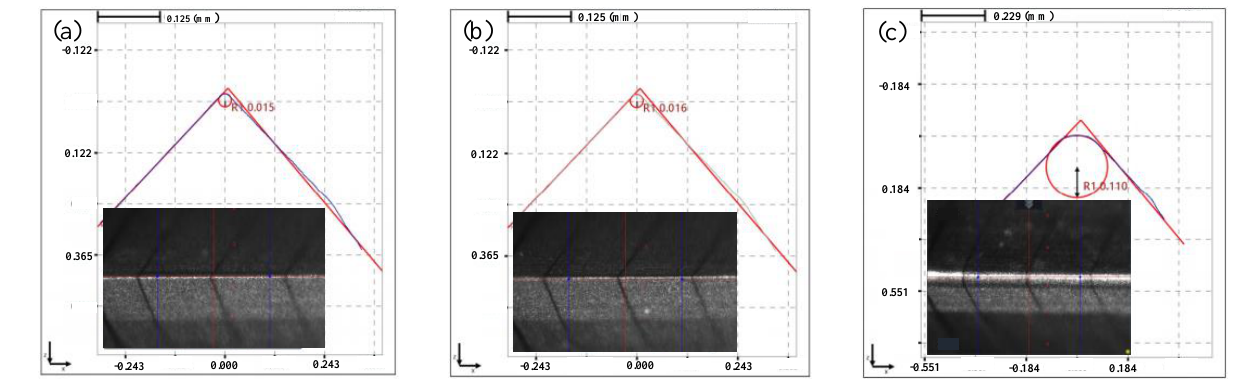
Figure 5. The edge shape diagram under different methods for 5 min: ( a ) initial, radius 15 μm . ( b ) STP, radius 16 μm . ( c ) FF-STP, radius 110 μm .